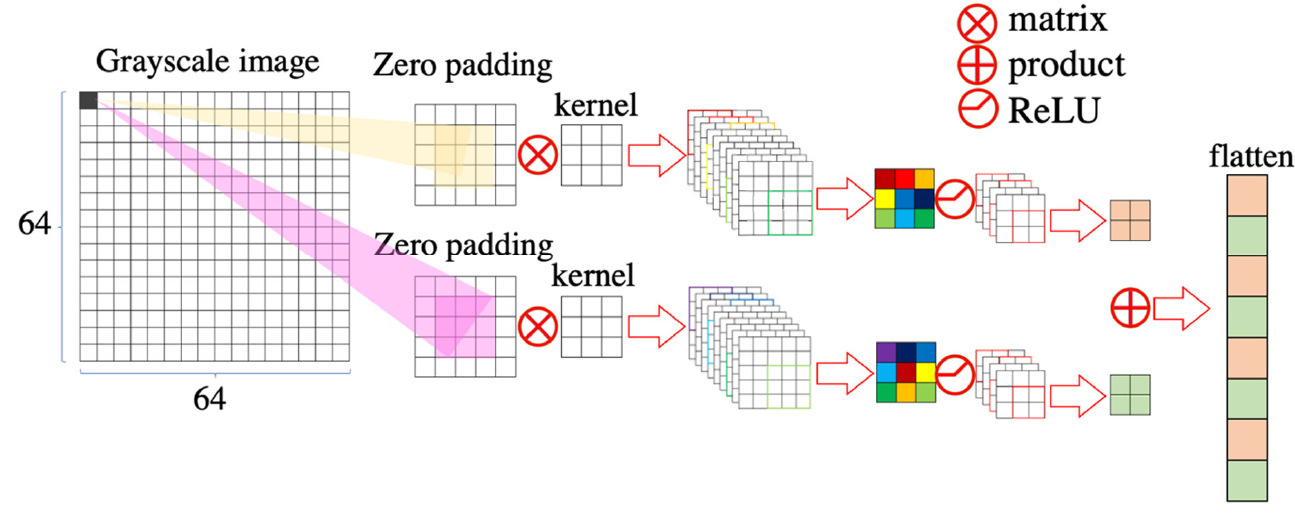
Figure 3. Analytical diagram of the actual convolution operation performed on the 3 × 3 kernel.